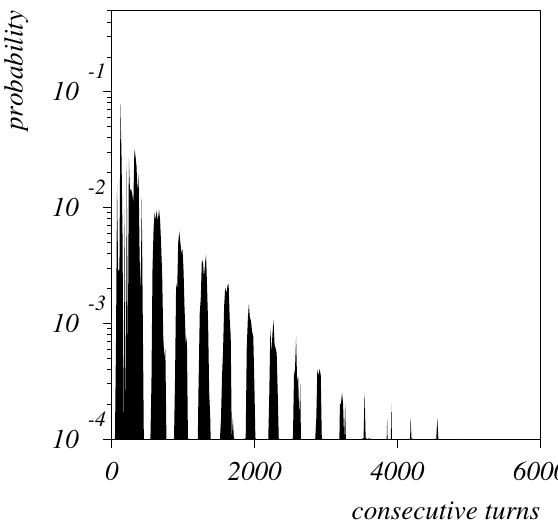
FIG. 9. Statistical evaluation of trapping and detrapping of a single test particle over 10 7 turns and Q probability with which a given particle stays continuously outside the ‘‘reference emittance’’ for a certain number of